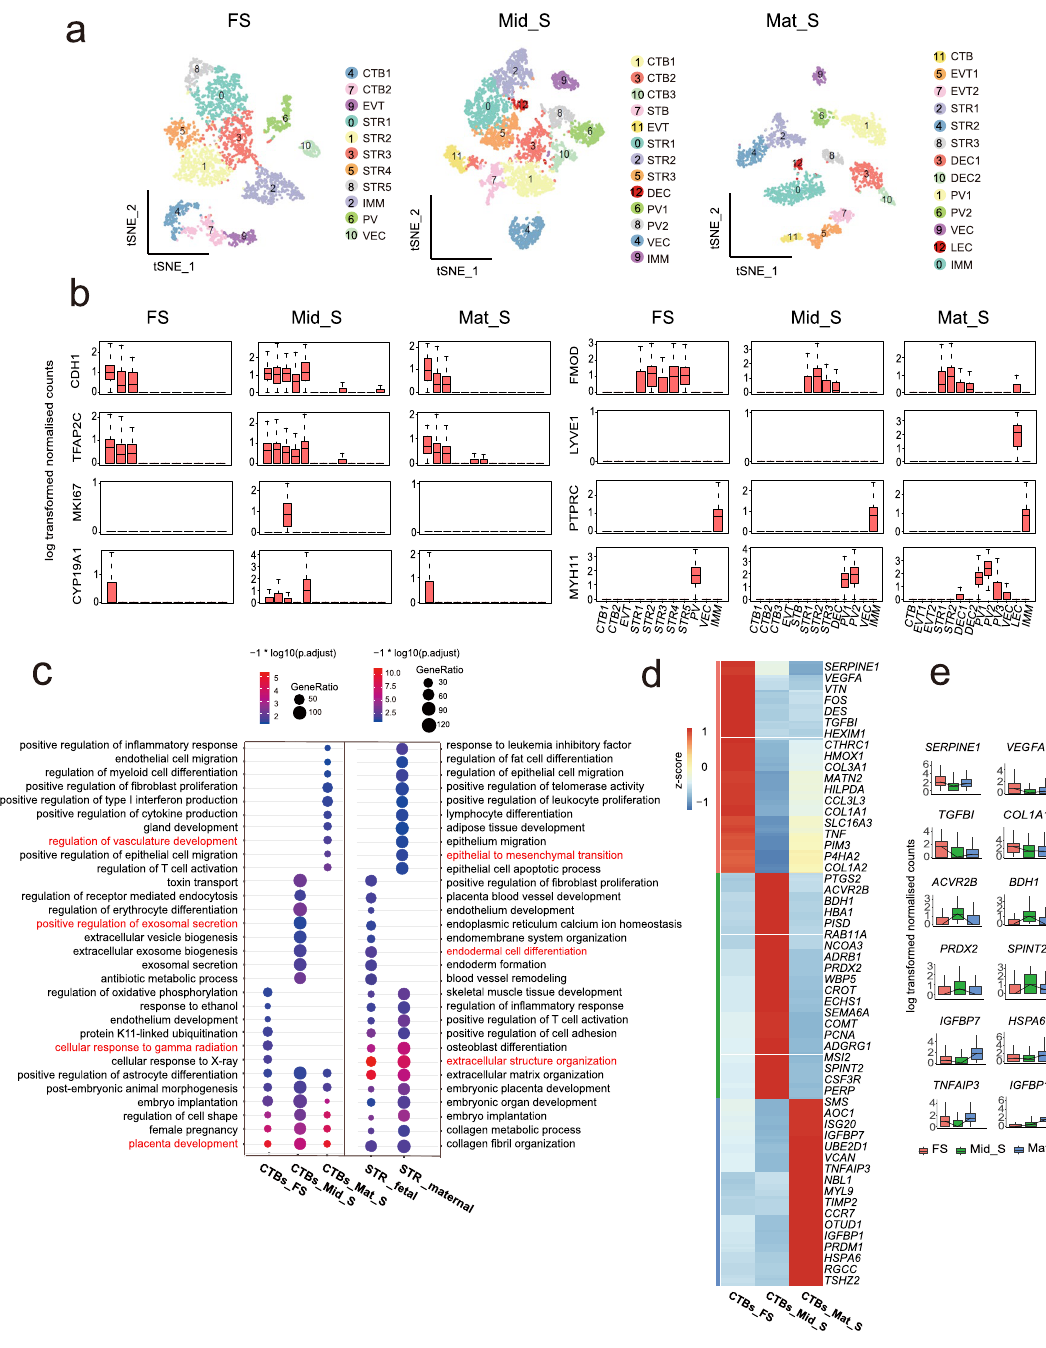
Figure 2. Reconstruction of spatial heterogeneity of cell type and gene expression pattern in the maternal– fetal interface. ( a ) T-distributed stochastic neighbor embedding (t-SNE) plots shows single-cell transcriptomic clustering of three specific tissue locations (including FS, Mid_S, Mat_S) in full-term maternal–fetal interface, respectively. Each dot represents an individual cell. Cells are colored by cell-type cluster. ( b ) Boxplot showing the relative expression levels of selected markers for each cell cluster. ( c ) Selected Gene Ontology (GO) terms identified by highly expressed genes of CTB in FS, Mid_S, and Mat_S, and STR of fetal and maternal origin, respectively. (Highly expressed gene: expressed cell number > 20%; gene coefficient of variability (CV) < 1 and mean greater than 0 in each section). ( d ) Heatmap showing the selected differentially expressed genes of CTB subpopulations derived from FS, Mid_S and Mat_S. Red corresponds to a high expression level; blue and black correspond to low expression level (the differentially expressed genes were identified by FindAllMarker function in Seurat, P_val_adj < 0.05; avg_logFC > 0.25). ( e ) Boxplots showing the expression of selected genes from figure ( d